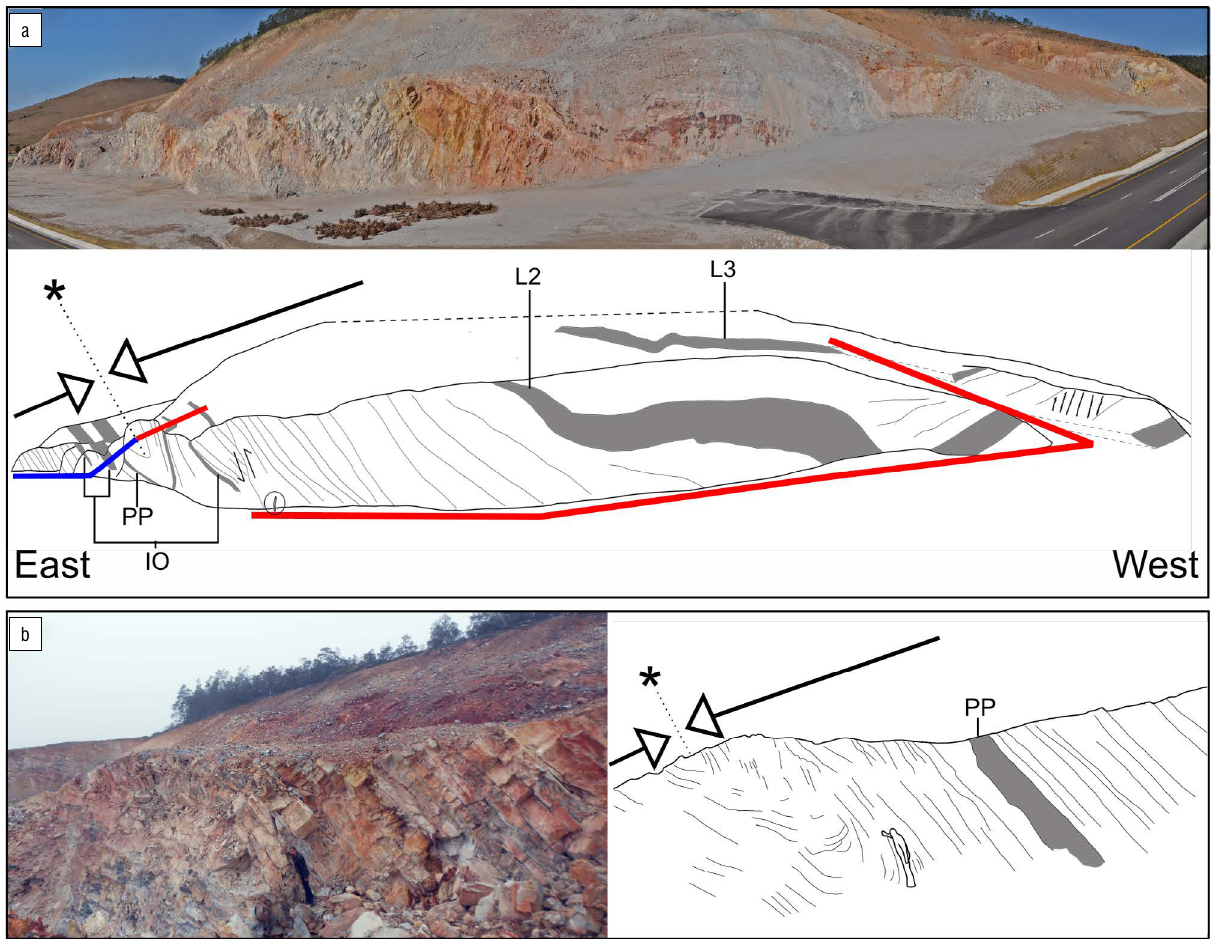
Figure 2: Geological structure of Coombs Hill. (a) Panoramic photograph of the road cutting with interpretive line drawing below. Arrows indicate younging direction of strata, which converge towards a fold axis (*); fossiliferous mudstone horizons are labelled (see Figure 3); the transect followed during systematic logging is indicated by a red line for the overturned strata and a blue line for the right-way-up strata; person for scale is circled. (b) Synclinal fold axis with interpretive line drawing to right, with arrows as in